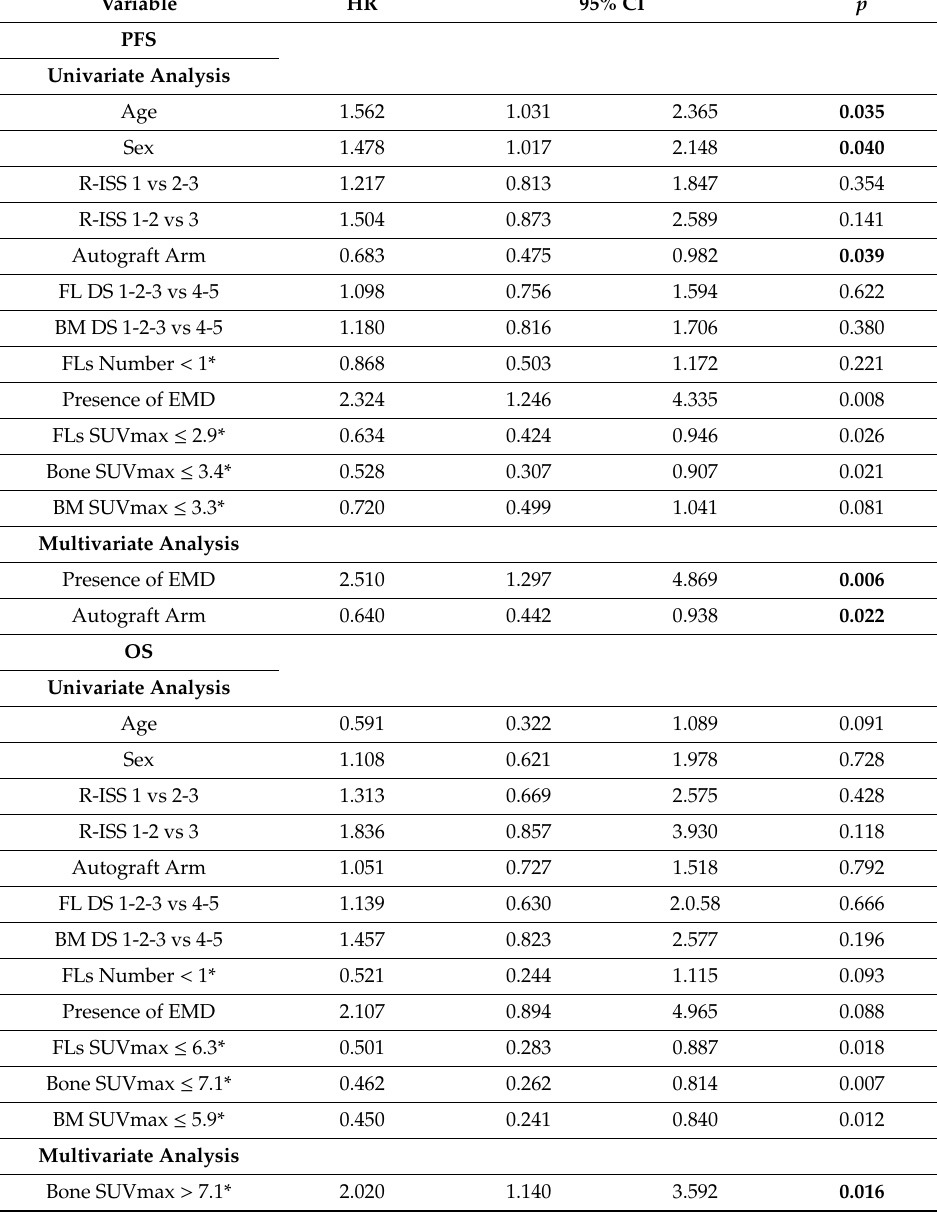
Table 3. Univariate and multivariate analysis of baseline variables on PFS and